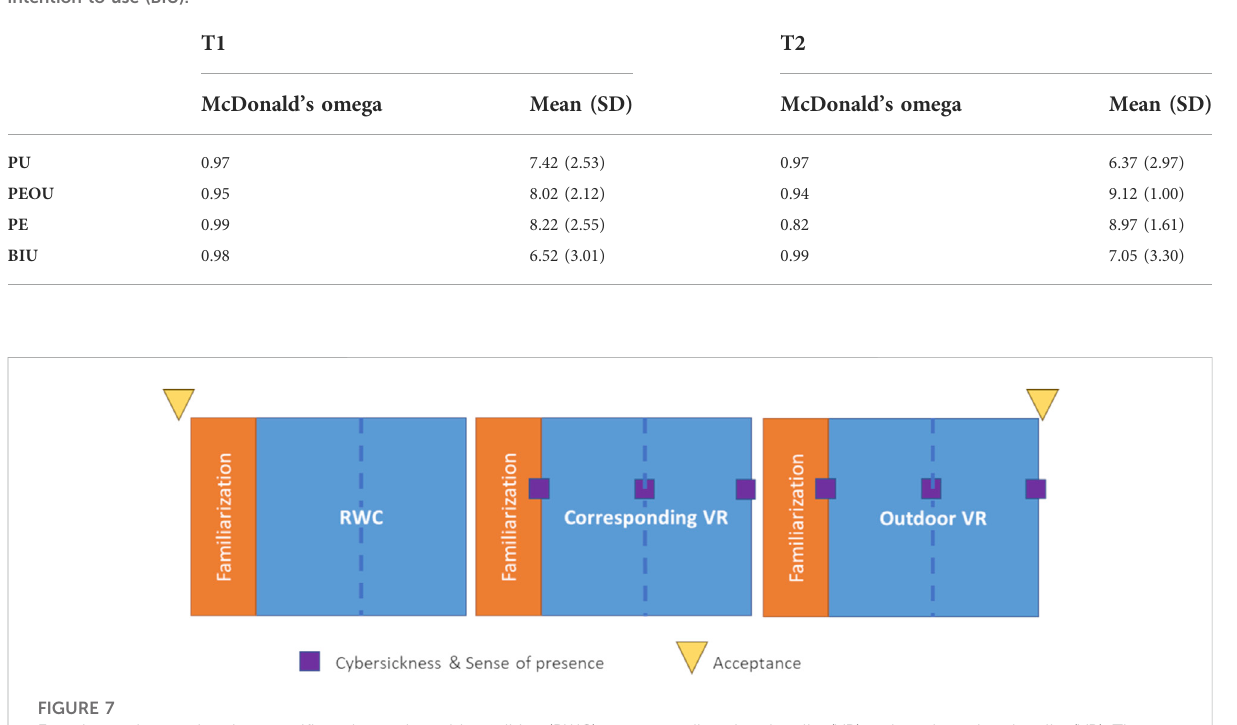
TABLE 1 McDonalds ’ s omega, mean and standard deviation (SD) of the four variables of acceptance at the beginning of the experiment (T1) and after the second virtual reality condition (T2): perceived usefulness (PU), perceived ease of use (PEOU), perceived enjoyment (PE), and behavioral intention to use (BIU).